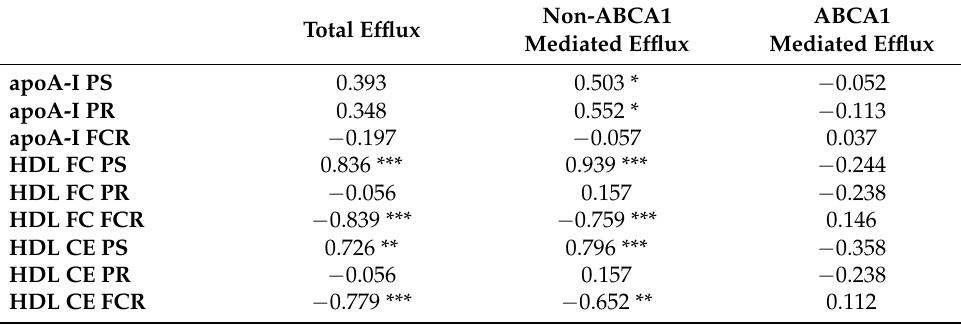
Table 4. Spearman correlation coefficients between apoA-I and HDL cholesterol kinetic parameters and ex vivo cholesterol efflux for combined subject groups ( n = 18). An asterisk (*) indicates p < 0.05, two (**) indicates p < 0.005, and three (***) indicates p < 0.0005. Total